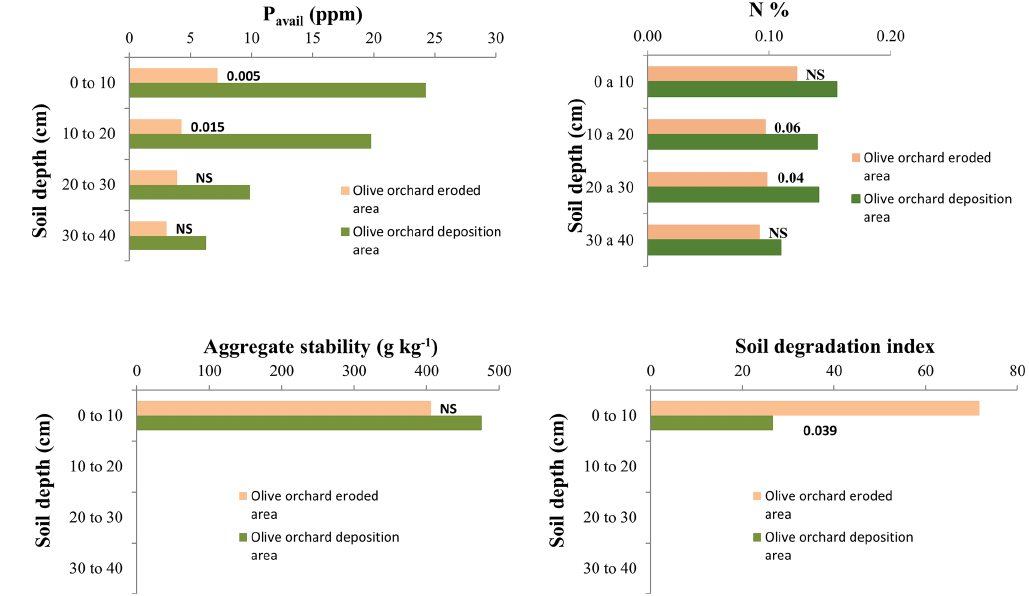
Figure 9. Soil available phosphorus (P avail ), organic nitrogen (N org ), aggregate stability ( W sagg ), and soil degradation index (SDI) by depth, comparing eroded vs. deposition areas within the olive orchard. The labels of the bars indicate the p value according to a one-way ANOVA comparing areas for the same soil depth.